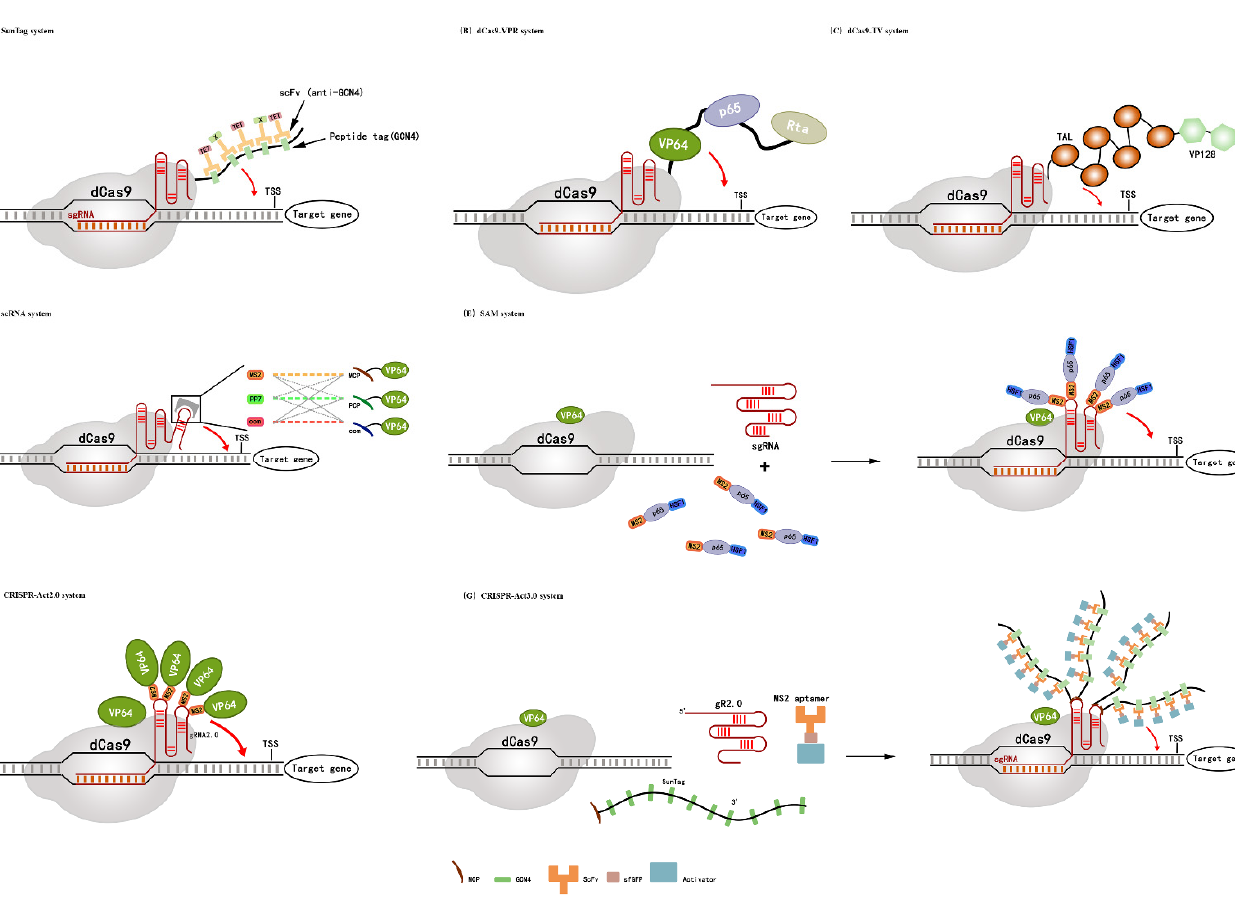
Figure 3. Schematic diagram of CRISPR transcriptional regulation. ( A ) Fusing dCas9 with inhibitors or transcriptional activators can provide additional inhibition (CRISPRi) or activation (CRISPRa) functions; ( B ) SunTag system: dCas9 fused with GCN4 to recruit multiple copies of scFv, TET and other element X to activate the target gene cooperatively; ( C ) dCas9-VPR system: dCas9 fused with VP64-p65-Rta to activate the target gene; ( D ) dCas9-TV system: dCas9 TV activation system includes 6 TAL and 2 VP128; ( E ) scRNA system: An RNA hairpin domain with RNA sequences MS2, PP7 and com recognized by MCP, PCP and com RNA binding proteins was introduced at the end of sgRNA, and the transcription activating element VP64 was fused into each corresponding RNA binding protein; ( F ) SAM system: The four bases at the distal end of the stem loops of gRNA were modified to recognize the stem loops of MS2 to bind p65 and HSF1; ( G ) CRISPR-Act2.0 system: dCas9 was fused with VP64 and the four bases at the distal end of the stem loops of gRNA were modified to recognize the stem loops of MS2 to bind VP64; ( H ) CRISPR-Act3.0 system: SunTag system with the MS2–MCP interaction would recruit more activator.